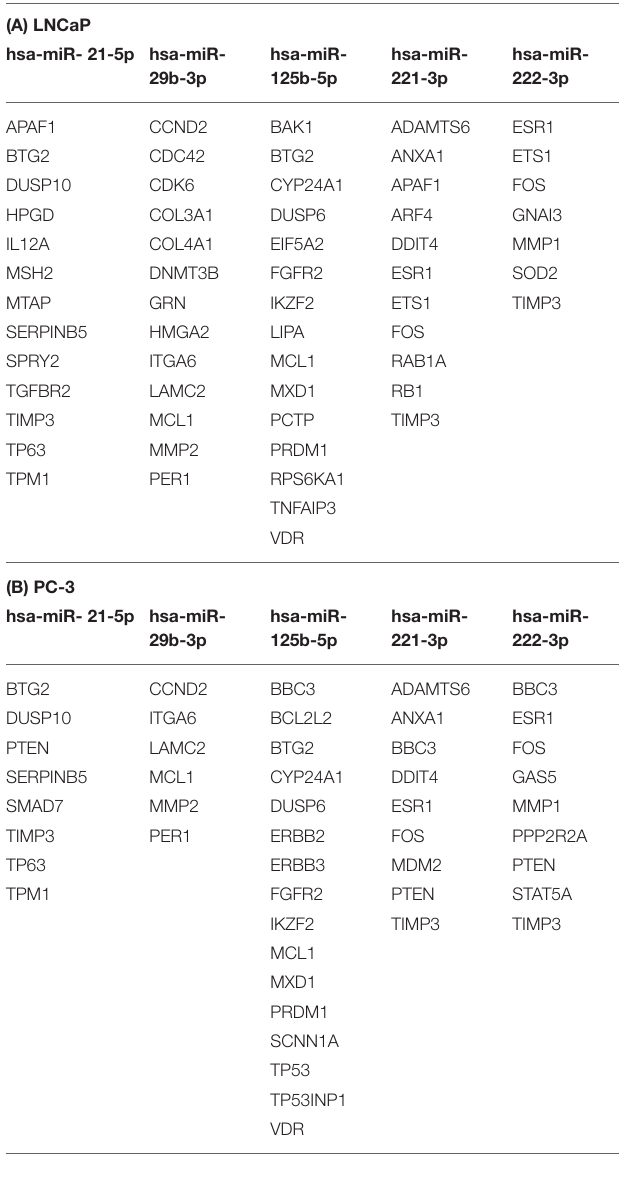
TABLE 2 | Target genes of differentially expressed